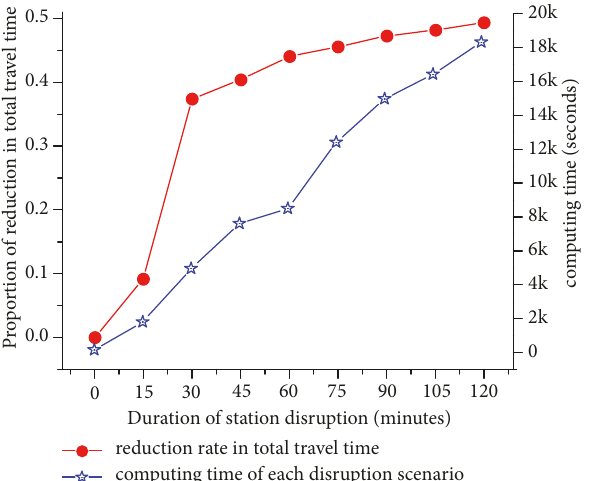
Figure 15: The optimization results under different disruption durations.